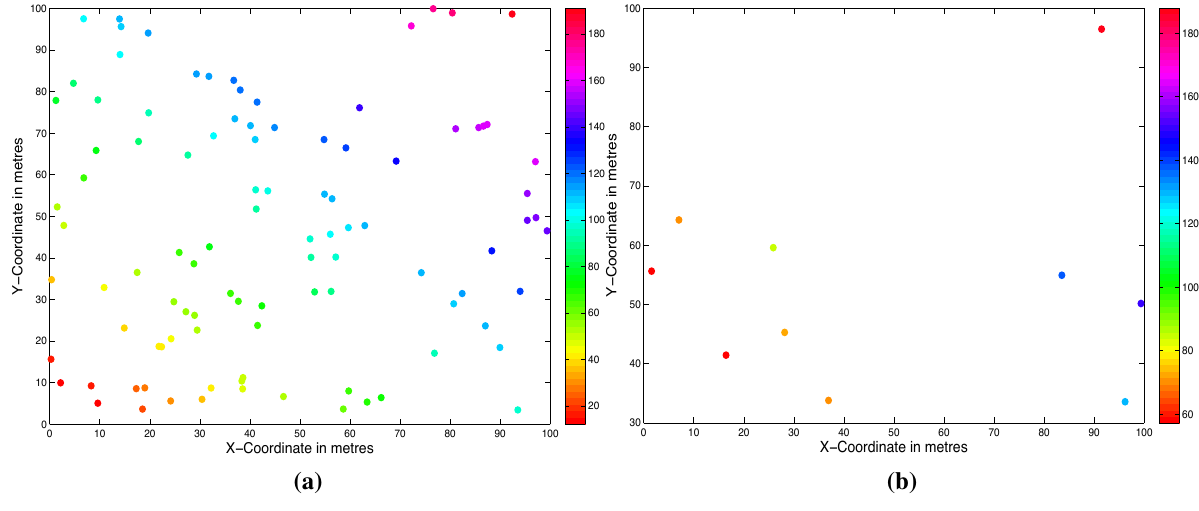
Figure 5. Sparsity of networked data in a Distributed Wavelet Transform (DWT)